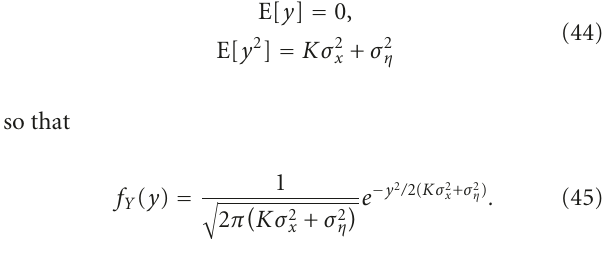
Table 4: The average number of flops for DLSD.